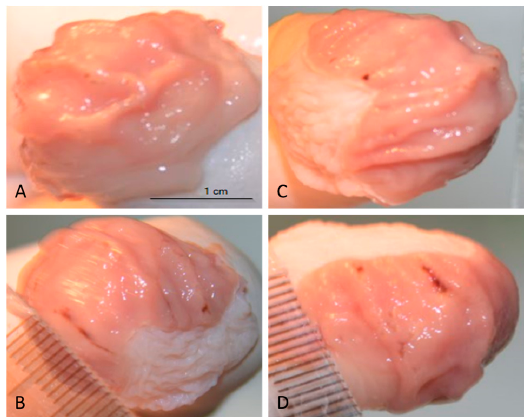
Figure 5. Representative images of gastric lesions in rats treated with spray-dried potato juice (SDPJ) ( A ) SDPJ 500 mg/kg alone; ( B ) rats treated with the mixture of HCl/ethanol alone; ( C ) SDPJ 200 mg/kg + HCl/ethanol; and ( D ) SDPJ 500 mg/kg + HCl/ethanol.